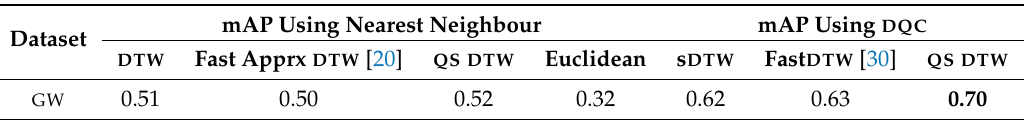
Table 6. Retrieval performance on the George Washington (GW) dataset. The DQC makes use of top 800 frequent classes for indexing the